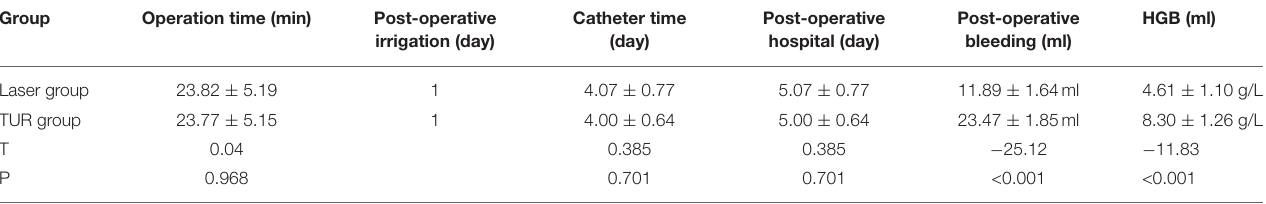
TABLE 2 | Perioperative indicators. Group